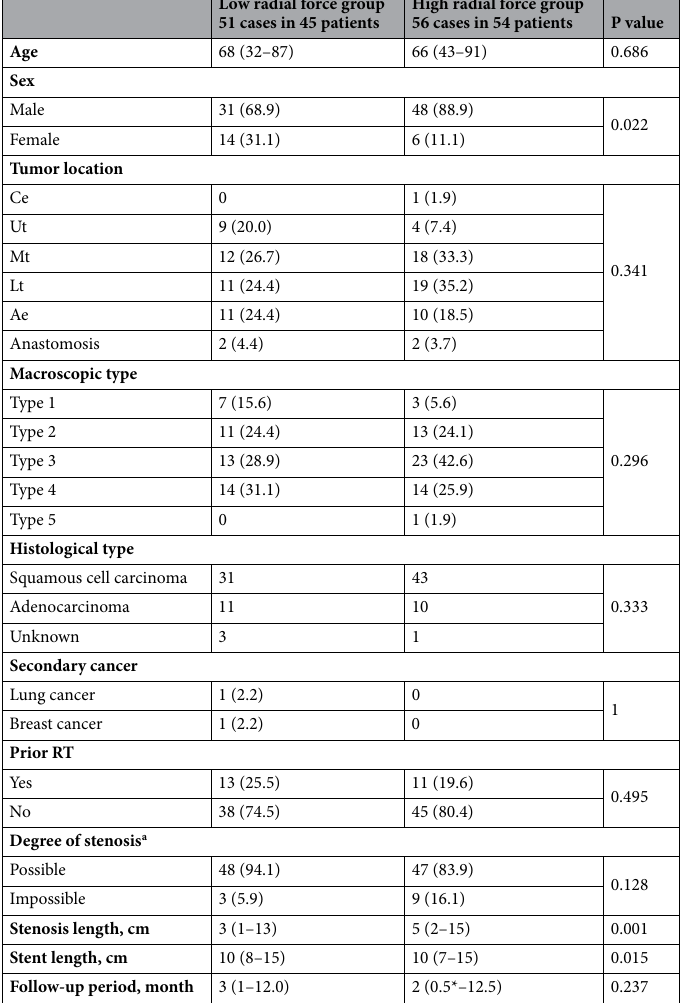
Table 1. Clinical characteristics of patients and pathological characteristics of lesions. Data are presented as median (range) or n (%). Quantitative data were compared using Mann–Whitney’s U test. Categorical data were compared using Fisher’s exact test. Ae, abdominal esophagus; Ce, cervical esophagus; Lt, lower thoracic esophagus; Mt, middle thoracic esophagus; Ut, upper thoracic esophagus. a Stenosis was evaluated by an approximately 6 mm diameter nasal endoscope. *Adverse events of less than 1 month are